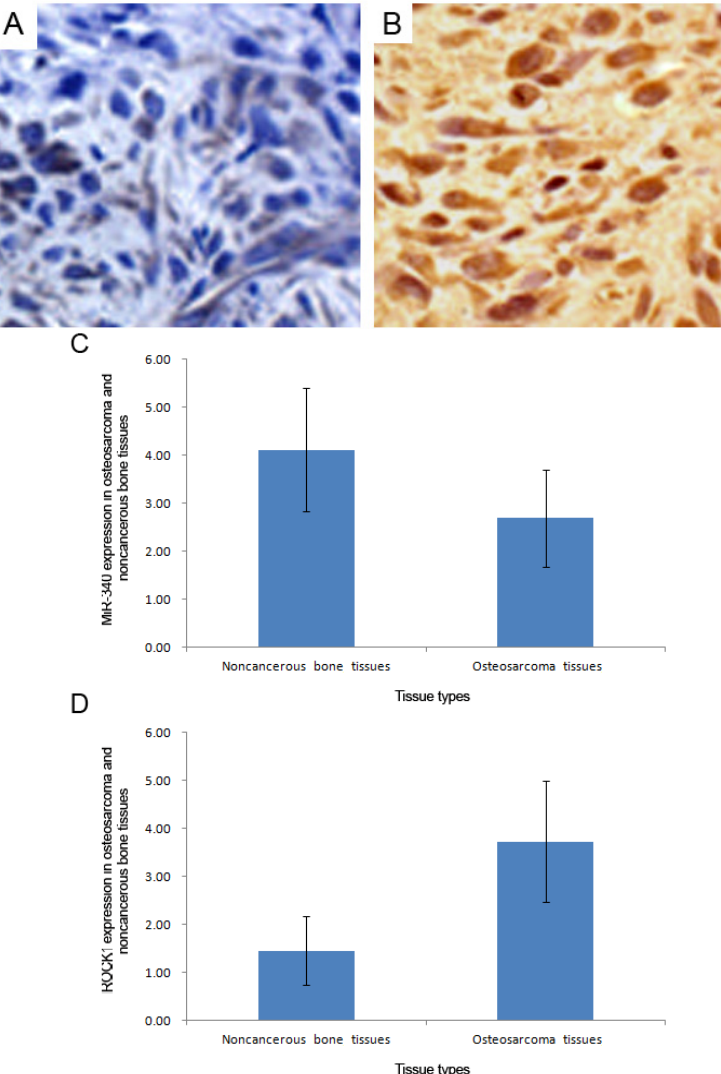
Figure 3. Representative in situ hybridization ( A ) and immunohistochemistry ( B ) images respectively for miR-340 and ROCK1 protein expression in osteosarcoma and corresponding noncancerous bone tissues (Original magnification ×200); Compared with the corresponding noncancerous bone tissues, the expression level of miR-340 (mean ± S.D.: 2.69 ± 1.01 vs. 4.11 ± 1.36, p < 0.001) ( C ) was significantly decreased, while the expression level of ROCK1 protein (mean ± S.D.: 1.40 ± 0.83 vs. 3.74 ± 1.25, p < 0.001) ( D ) was significantly increased in osteosarcoma